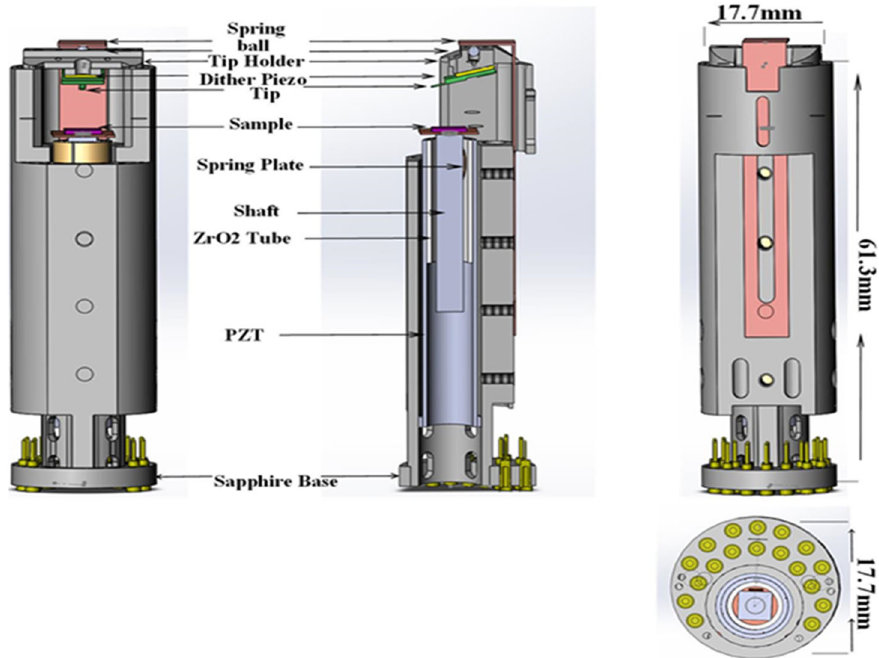
Figure 3. MFM head view (left) with side image (middle). The MFM’s internal side view (top image) and bottom side (lower image) are shown in the images on the right.